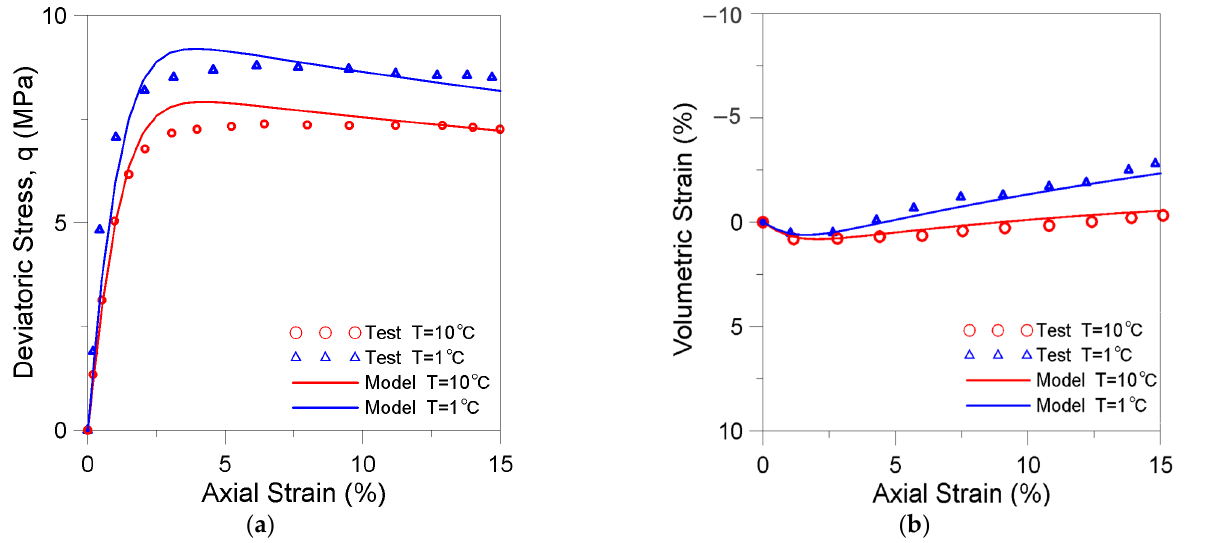
Figure 11. Modeling the tests reported in Hyodo et al. [6] at different temperatures. ( a ) Deviatoric stress versus axial strains; ( b ) volumetric strain versus axial strains.